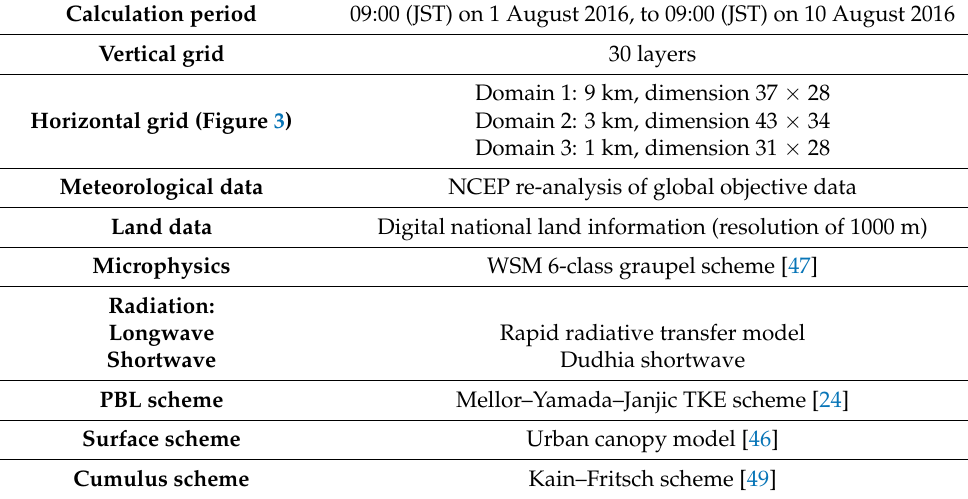
Figure 3. Definition of the three domains for the WRF model. Table 2. Domains and parameterization schemes used in WRF model experiments.